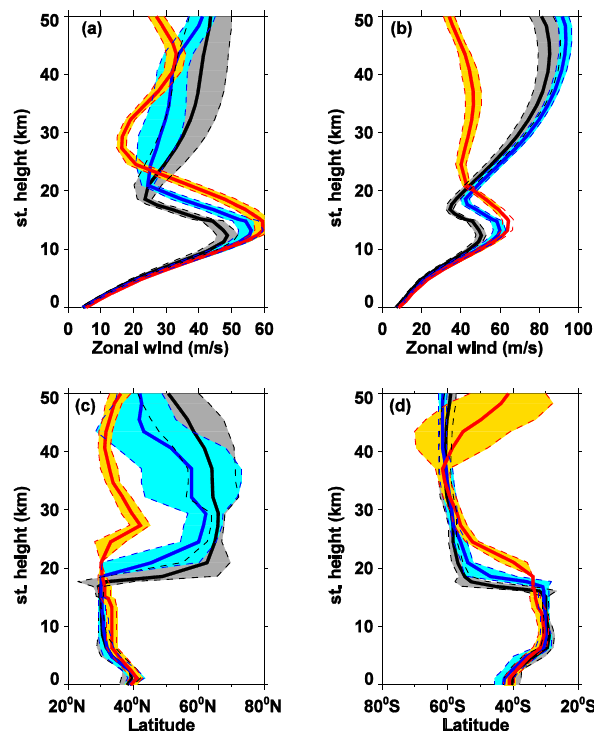
Fig. 2. Zonal wind speed (a, b) and latitude of the jet maxima (c, d) for the boreal winter in the Northern Hemisphere (a, c) and austral winter in the Southern Hemisphere (b, d) . The results are for the years 1987–2012 (black lines) and 2090–2100 (blue lines) of the reference run and for the years 2090–2100 of the noMPA run (red lines). The shading indicates standard